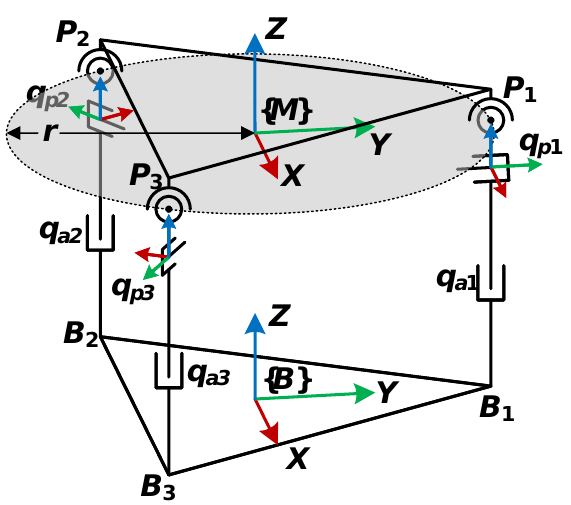
Figure 2. Kinematic diagram of the proposed 2R1T 3PPS PKM. For the zero-torsion 3PPS parallel mechanism, our previous work [30] proposed two parameters ( u x , u y ) to describe the orientation of the moving platform, as shown in Figure 3. Parameters u x and u y represent the x and y coordinates of the unit z axis vector of the moving platform with respect to frame M 0 , respectively. It is noted that frame M 0 is attached to the origin of moving platform frame M with the same orientation as the base frame B . The proposed orientation description is intuitive, as the orientation of the moving platform is equivalent to rotation about a unit axis k parallel to the base plate.